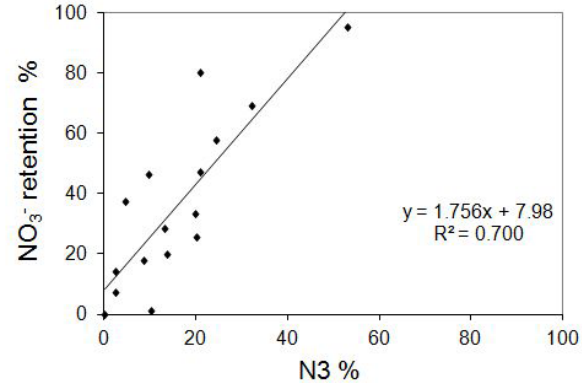
Fig. 7. Relationship between NO 3 retention in catchment outflow and tundra (N) percentage, for high-elevation watersheds of the Val